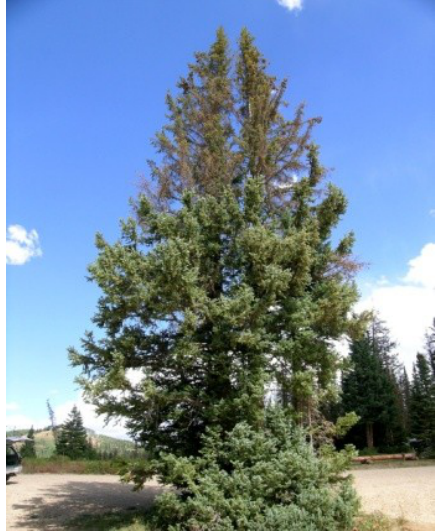
Figure 4. Engelmann spruce topkill due to inadequate height coverage on the tree bole using ground application equipment to apply insecticide (Photo: A. Steven